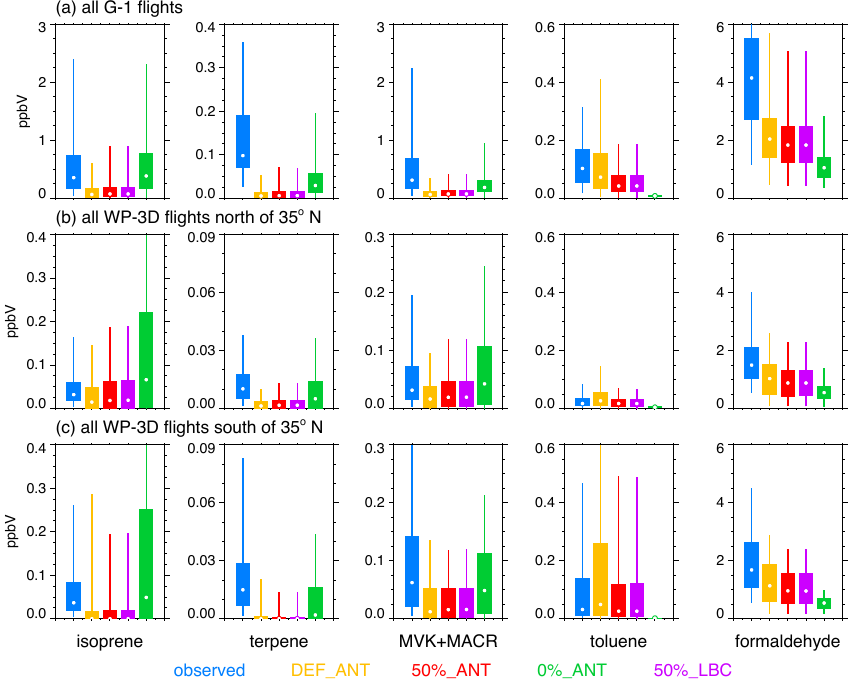
Figure 7. Percentiles as a function of height for isoprene, monoterpenes, methyl-vinyl-ketone + methacrolein (MVK + MACR), toluene, and formaldehyde for all (a) G-1 flights (b) WP-3D flights north of 35 ◦ N, and (c) WP-3D flight flights south of 35 ◦ N. Vertical lines denote 5th and 95th percentiles, boxes denote 25th and 75th percentiles, and the white dots denote the 50th percentiles. Note that formaldehyde was not measured on the G-1, but the model results are included for